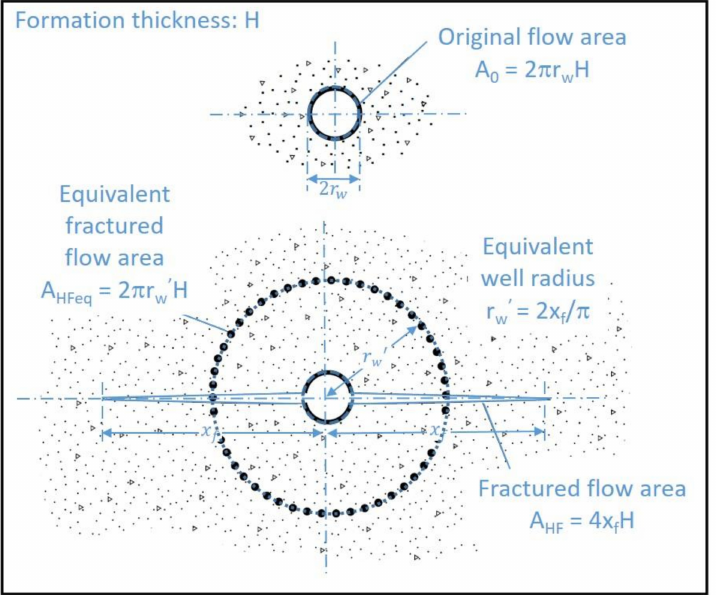
Figure 10. Equivalent wellbore radius, r (cid:48) w , for drainage area in terms of fracture half length, x f , in conventional reservoir